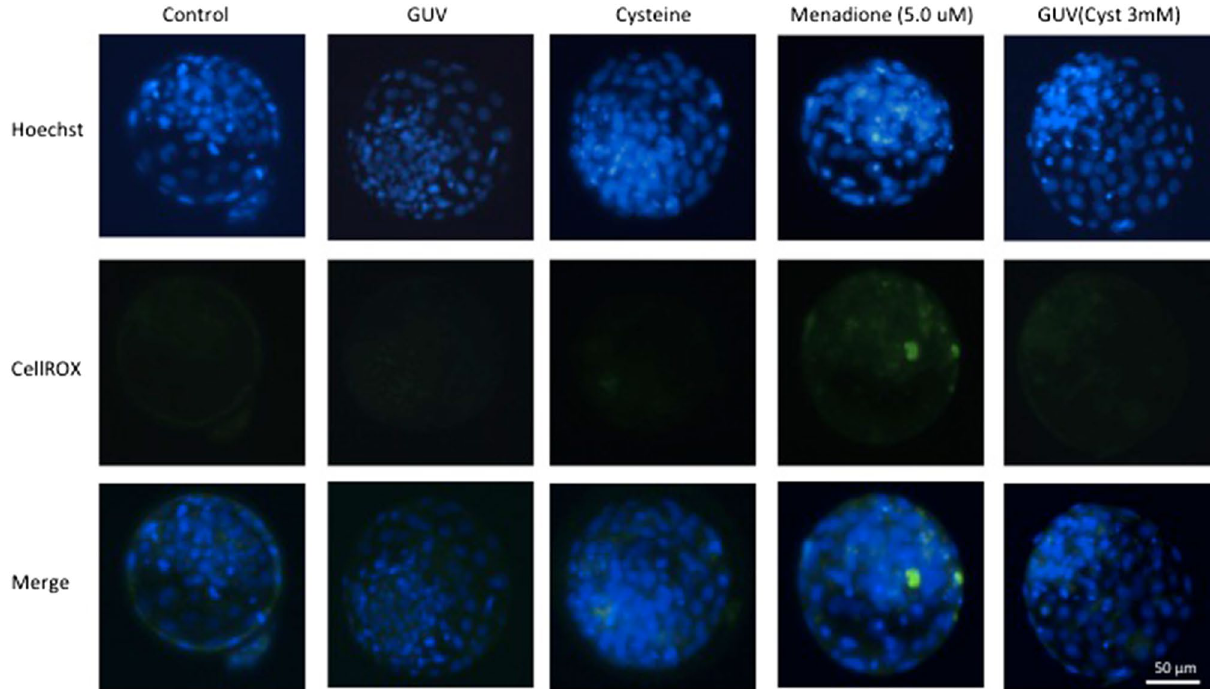
Figure 5. Representative photomicrographs of embryos from the different treatments stained for reactive oxygen species detection (CellROX Green Reagent = green) and DNA (Hoechst =